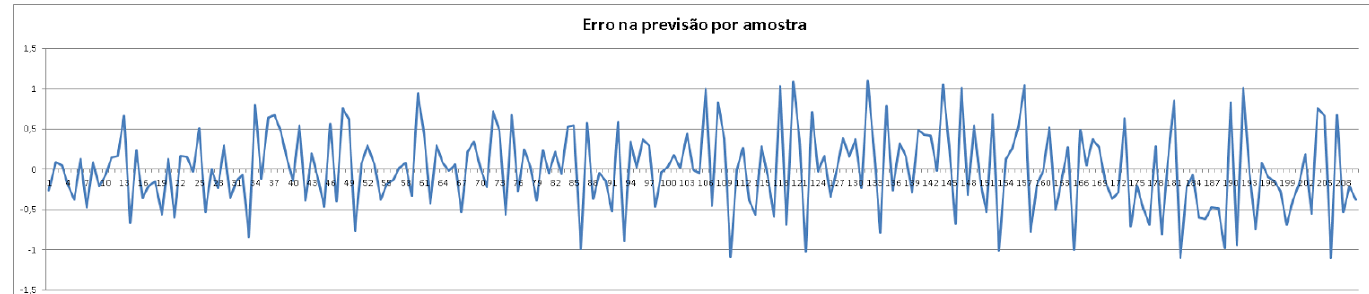
Figura 4: Gráfico do erro da previsão do volume de vendas de petróleo. Fonte: Autores, (2017).